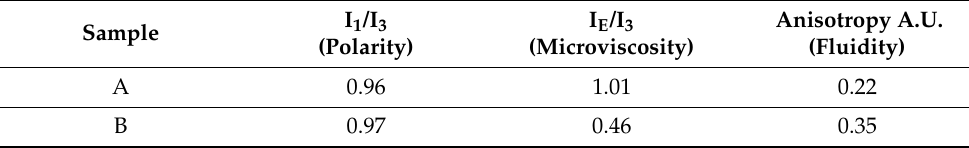
Table 4. Bilayer characterization. (SD values are all in the range ± 0.01–0.02).